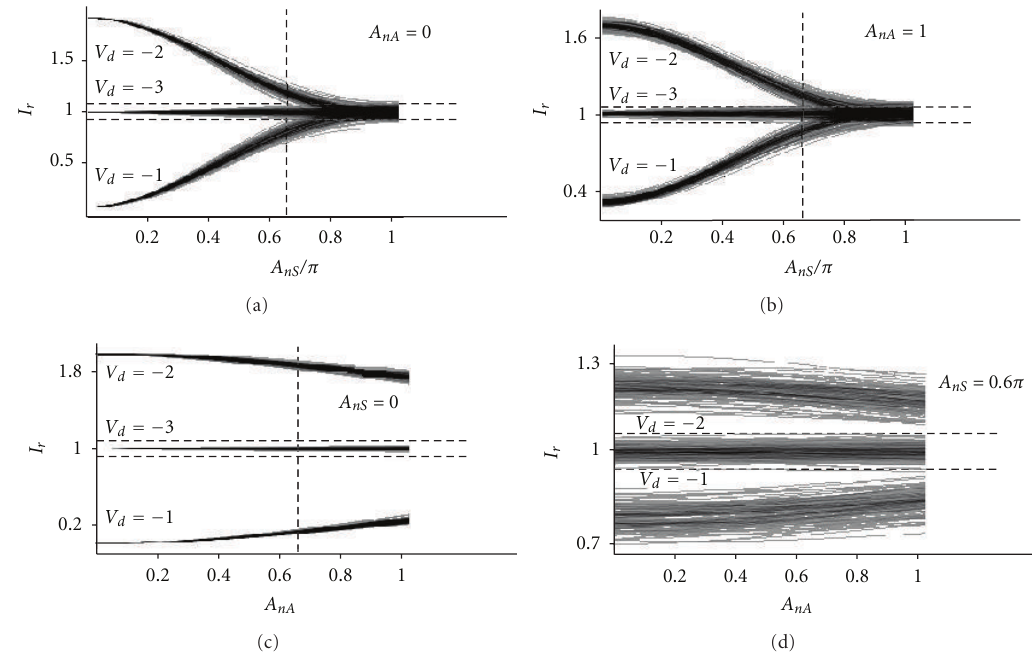
Figure 3: The same results as in Figure 2 obtained with Δ = 120 ◦ and ϕ = π/ 2. The vertical dashed line corresponds to A nS = 0 . 64 π , while horizontal dashed lines correspond to relative intensity I r equal to 0.94 and to